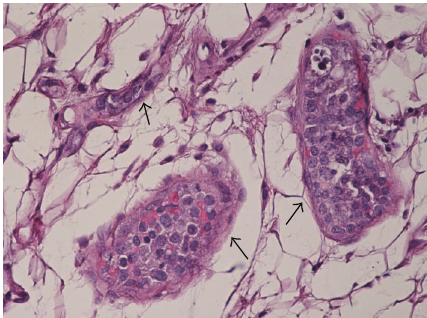
Figure 2: Histopathology of fat pad biopsy showing intravascular large B cell lymphoma cells mainly located in lumina of small vessels (arrows).